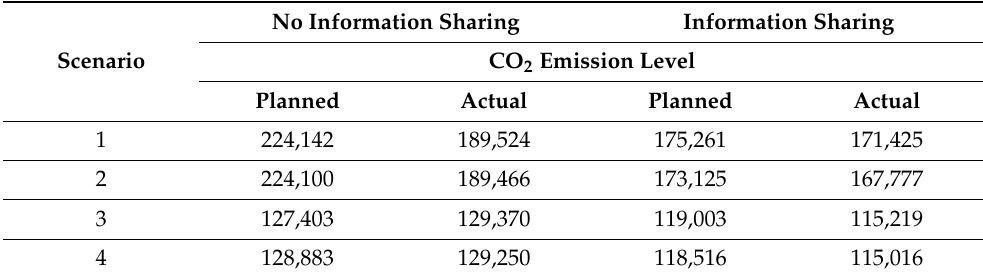
Table 6. Model output of the planned CO 2 emission level and actual values obtained by the model (numbers represent the average simulated period).